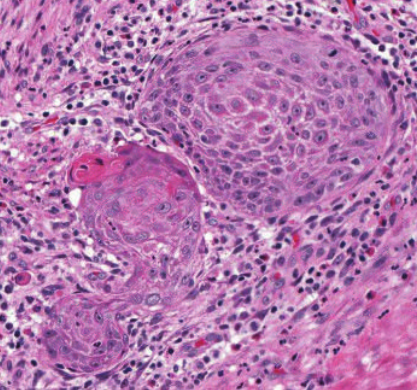
Figure 5: Area extracted from the whole slide image showing cytologic detail and mitotic figure